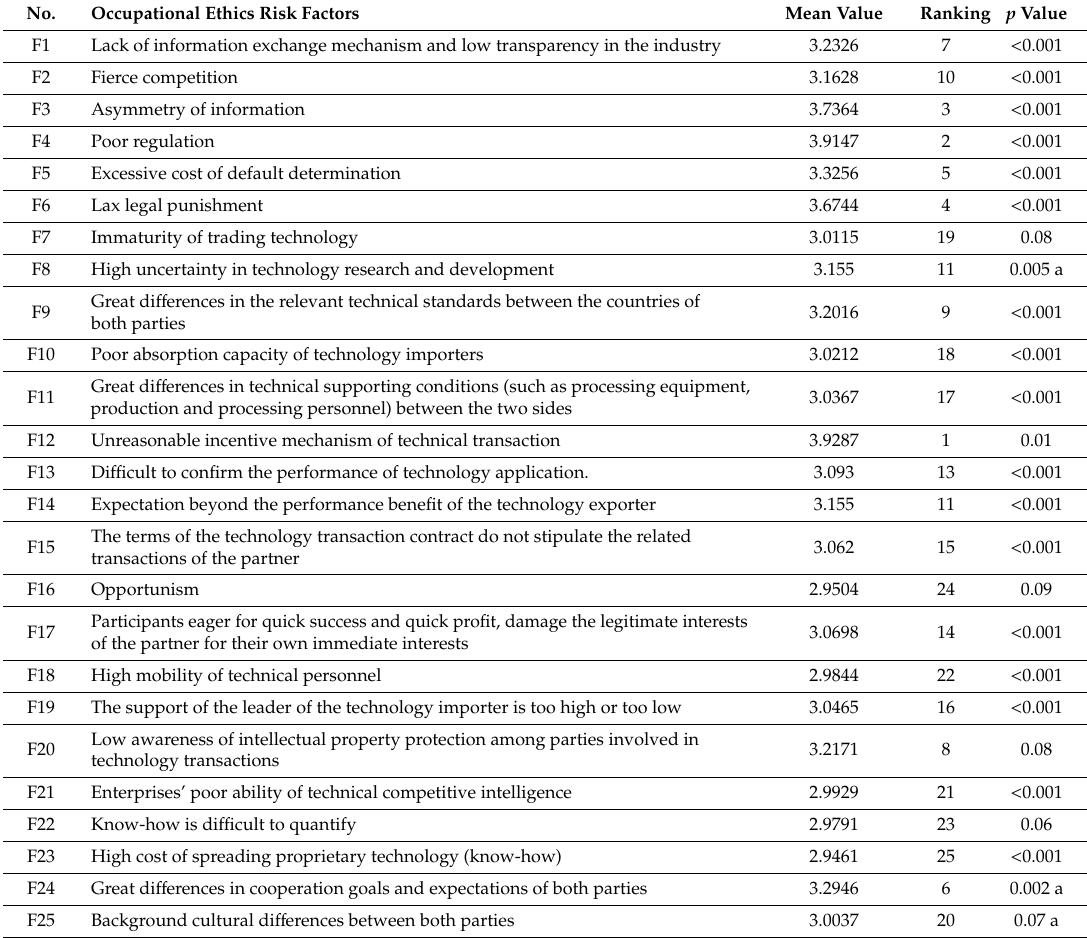
Table 2. Ranking of occupational ethics risk